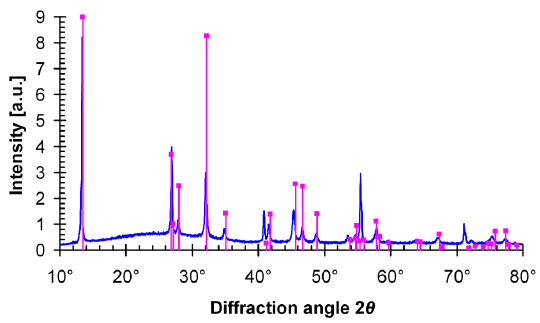
Figure 2. Diffraction pattern of prepared NaLuS 2 :Eu sample compared with ICDD PDF ‐ 2 record.